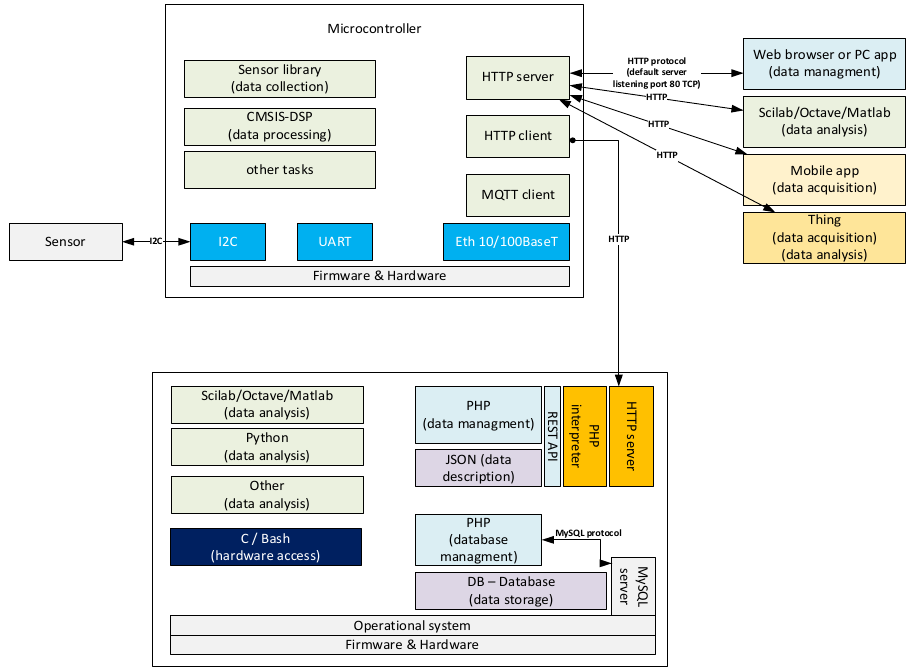
Figure 4. Client–server architecture with